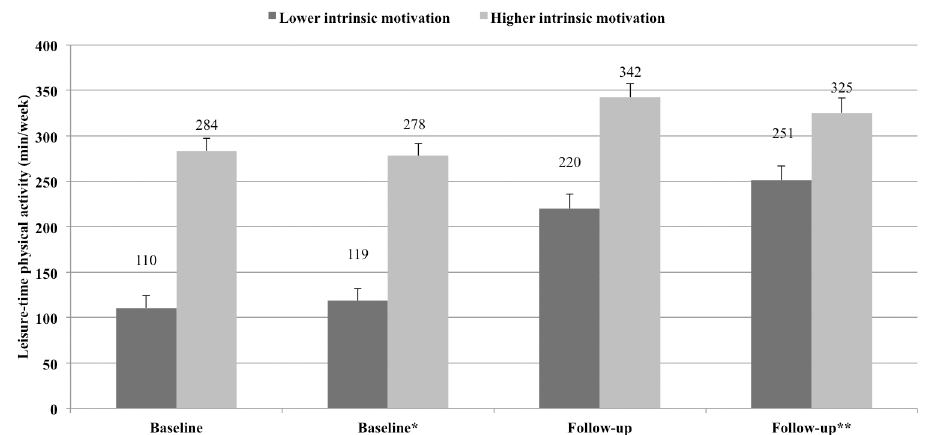
Fig 2. Associations between intrinsic motivation and leisure-time physical activity at baseline and at follow-up (between-group comparisons of estimated marginal means with linearly independent pairwise tests: baseline — mean dif. = -173 min/week, 99% CI = -223, -124; baseline * — mean dif. = -159 min/week, 99% CI = -209, -110; follow-up — mean dif. = -122 min/week, 99% CI = -175, -69; follow-up ** — mean dif. = -74 min/week, 99% CI = -131, -18). Note: Groups represent the lowest and highest tertile-split groups of adjusted intrinsic motivation means at baseline. At baseline, adjustments were made for